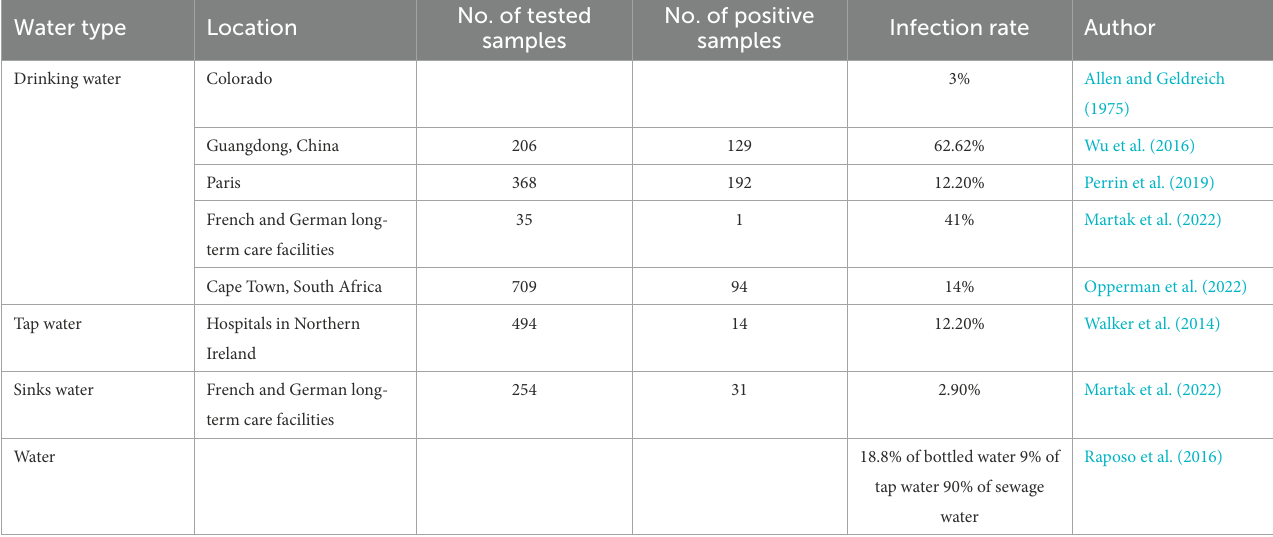
TABLE 1 Prevalence of Psuedomonas aeruginosa in different types of